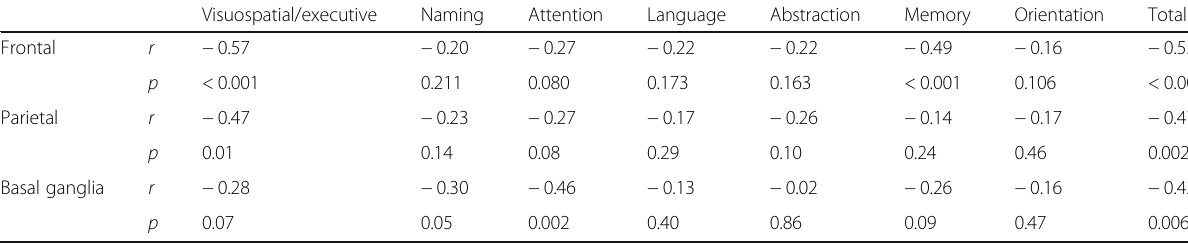
Table 5 Partial correlation between MoCA test cognitive indices Visuospatial/executive